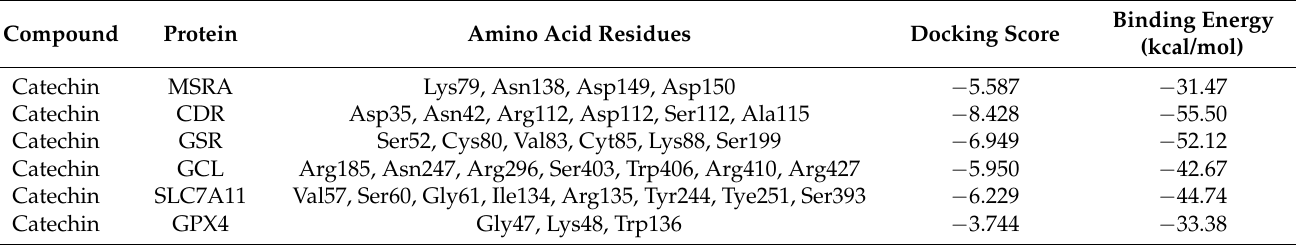
Table 3. The binding energy for catechin with related